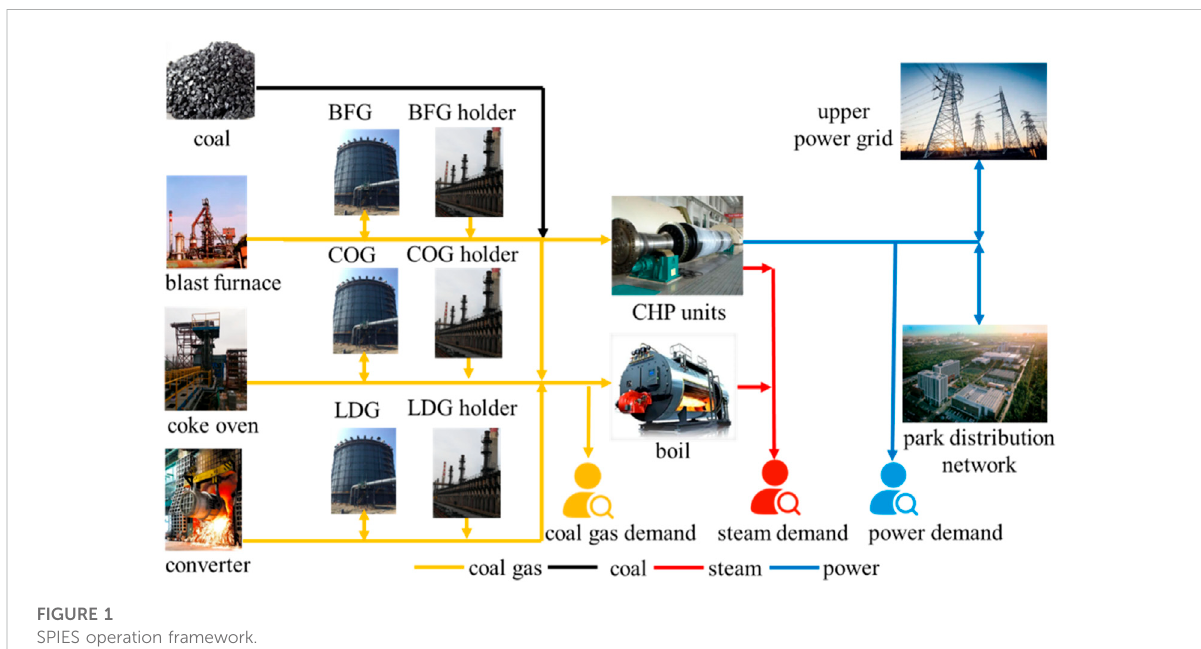
FIGURE 1 SPIES operation